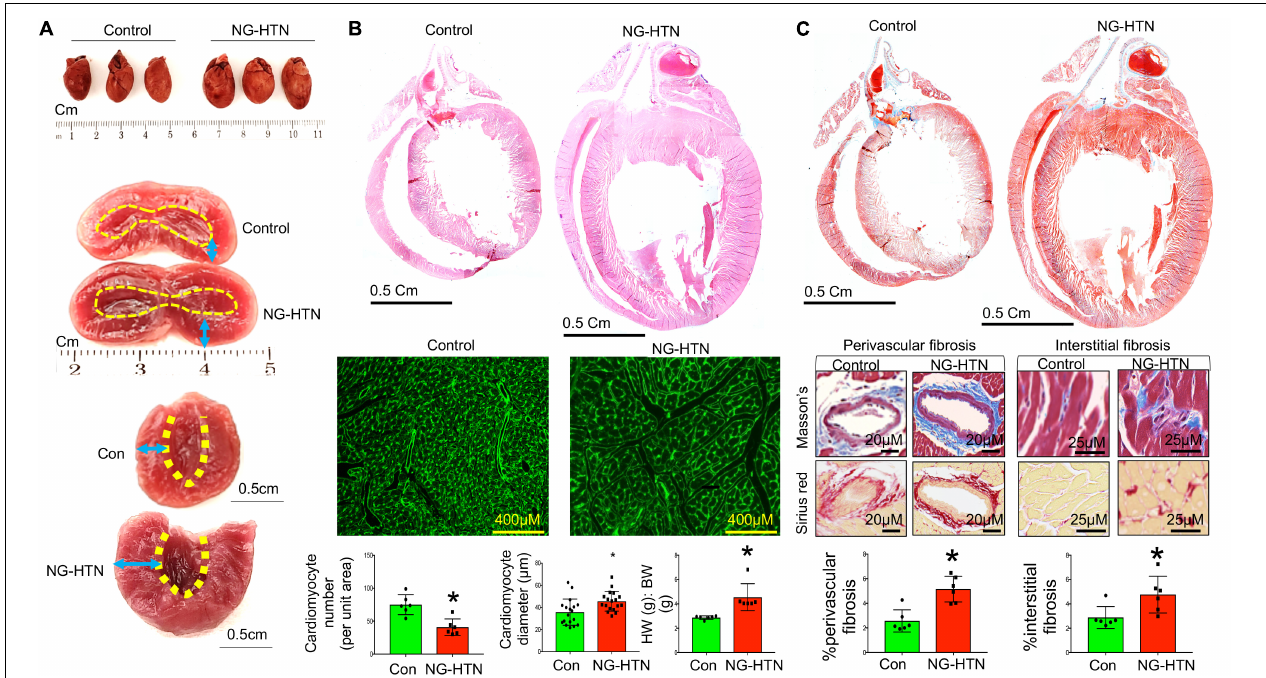
FIGURE 2 | Neurogenic hypertension induces cardiac hypertrophy and fibrosis. (A) Top, whole heart images of control and NG-HTN hearts, n = 3. Middle, representative image showing exposed hearts chambers. Bottom, endocardium outlined with dotted line, arrow space highlights wall thickness. (B) Top, HE stained images showing longitudinal whole heart sections of control and NG-HTN rats. Middle, WGA-488 staining of heart sections, green represents cardiomyocyte boundaries stained with WGA. Bottom, quantifications of cardiomyocyte numbers (each dot represent number of cardiomyocytes count per image, n = 6 rats) and cardiomyocyte diameter ( µ m, per unit area, each dot represent individual cardiomyocytes diameter per section from n = 6 rats), and heart weight (HW) to body weight (BW) ratio in control vs. NG-HTN rats, n = 6 rats. (C) Top, representative Masson’s trichrome (MT) stained longitudinal whole heart sections, blue represents collagen staining. Middle, representative MT (blue), and Picrosirius (red) images of whole heart sections showing perivascular and interstitial fibrosis. Bottom, quantification for % fibrosis in control and NG-HTN rats, each dot represents Mansson’s blue intensity per unit area. Values are presented as mean ± SEM, n = 6. * P < 0.05 vs. Control, Student’s t